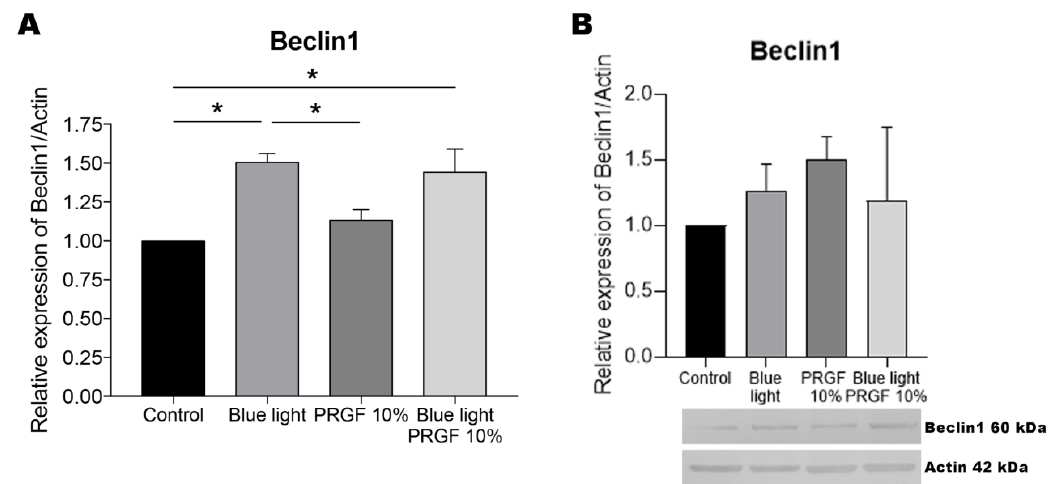
Figure 7. Beclin1 gene expression, and protein expression relative to the expression of actin. ( A ) Beclin1 gene expression measured by qPCR. Results indicate that in response to blue light with or without PRGF its gene expression was signifi- cantly increased compared to the control treatment. One-way ANOVA, Tukey ’ s multiple comparison test, * p < 0.05 ( n = 4). ( B ) Beclin1 protein expression measured by Western blotting. Results indicate no significant difference in protein ex- pression among the treatments. One-way ANOVA, Kruskal – Wallis multiple comparison test ( n = 4).